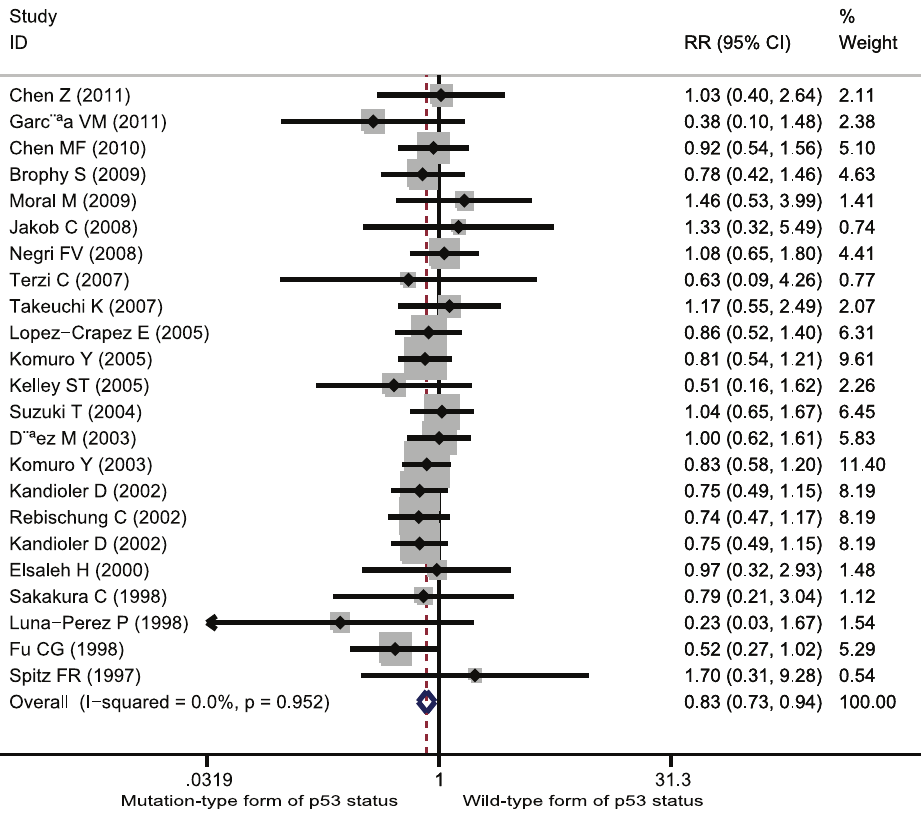
Figure 4. Forest plots of RR were assessed for association between p53 and poor response among rectal cancer patients treated with neoadjuvant radiation-based therapy.